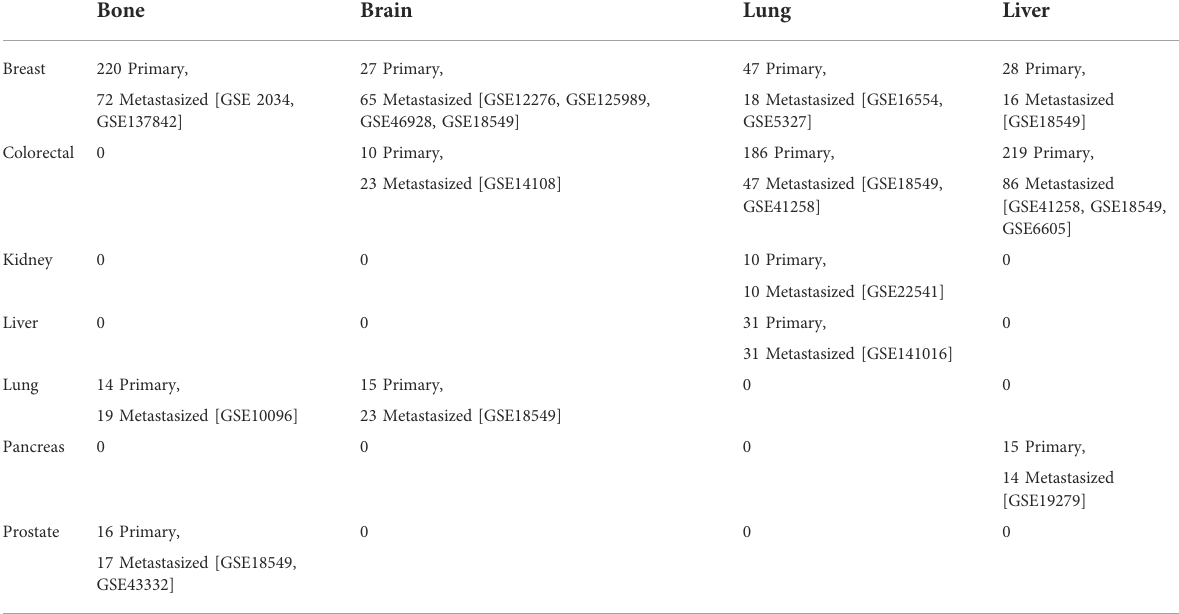
TABLE 1 The gene expression datasets from GEO with the number of primary and metastasized samples for each site. Bone Brain Lung